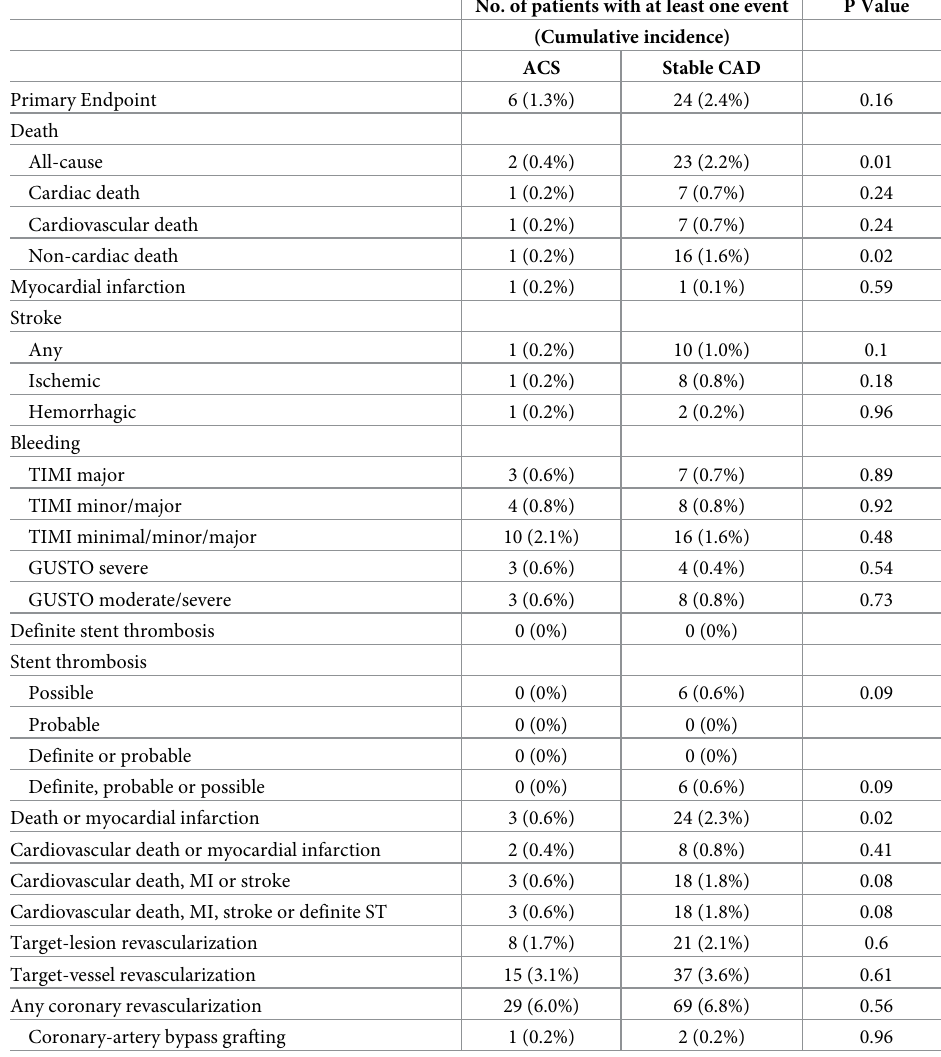
No. of patients with at least one